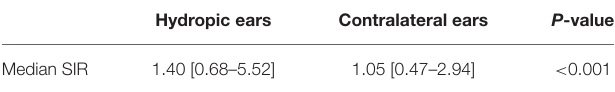
TABLE 3 | Clinical diagnosis of the included and excluded patients according to the 2015 AAO-HNS criteria.